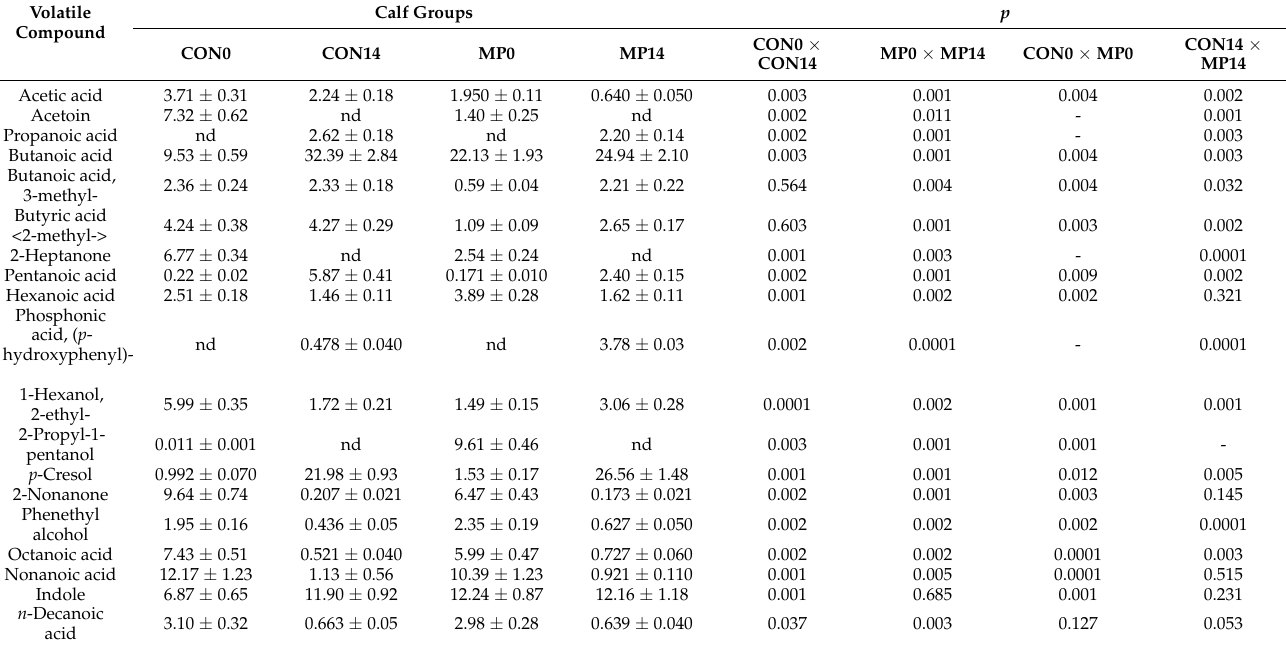
Table 4. Volatile compound percentage profiles of faeces in the calf group fed with milk replacer only (CON0 and CON14 group) or supplemented with fermented milk permeate (MP0 and MP14